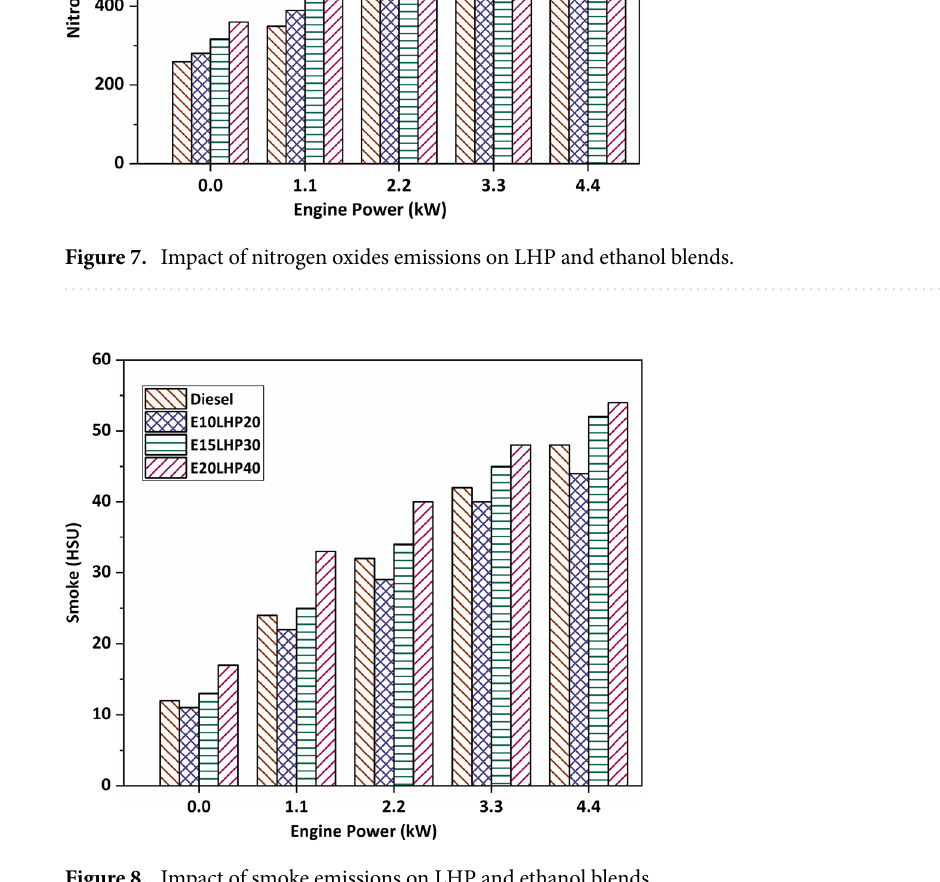
Figure 8. Impact of smoke emissions on LHP and ethanol